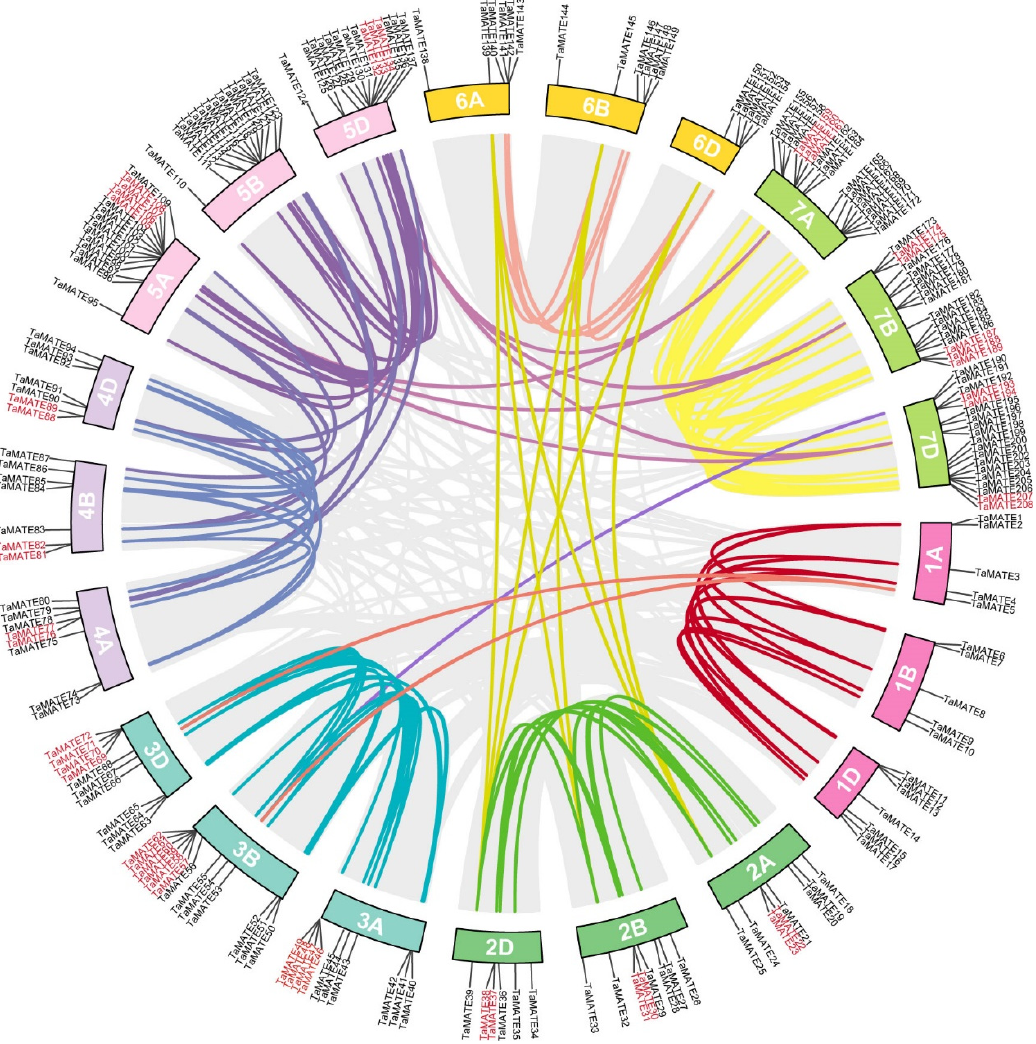
Figure 3. The gene distribution and duplication events of MATE gene family members in wheat chromosomes. The different colour lines represent the segmental duplication pairs between the TaMATEs and the gray lines represent the segmental duplication pairs in the whole maize genome. The red marked TaMATE genes represent the tandem duplicated genes in the whole wheat genome.